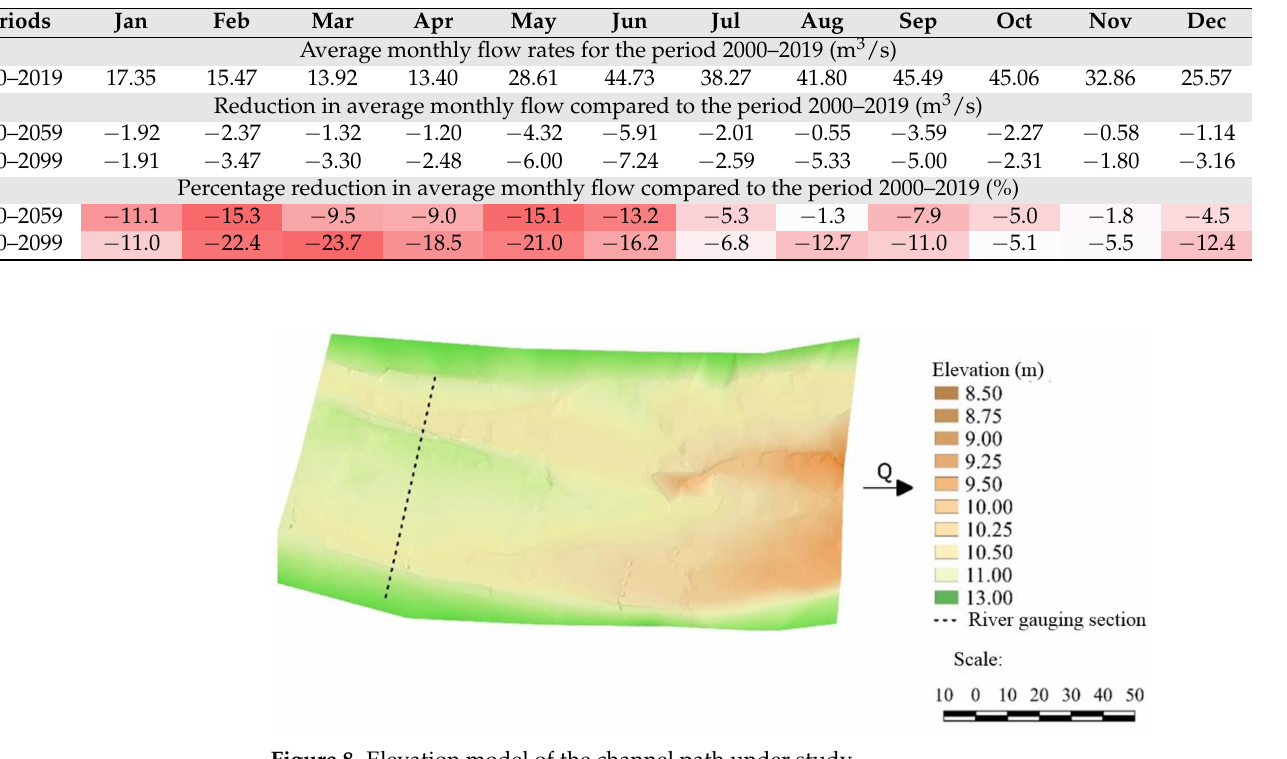
Table 5. Quantification of the effects of climate change on monthly average flows.